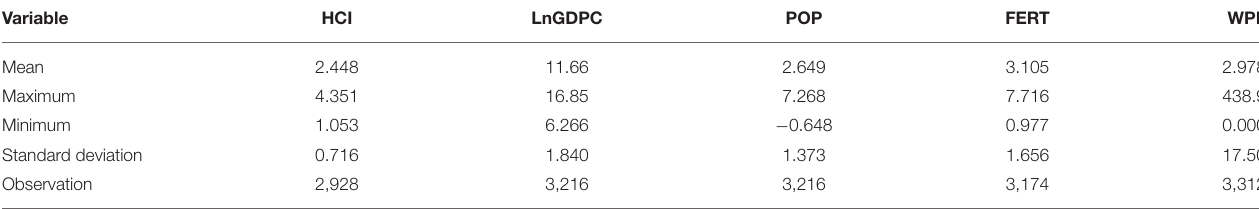
TABLE 1 | Descriptive